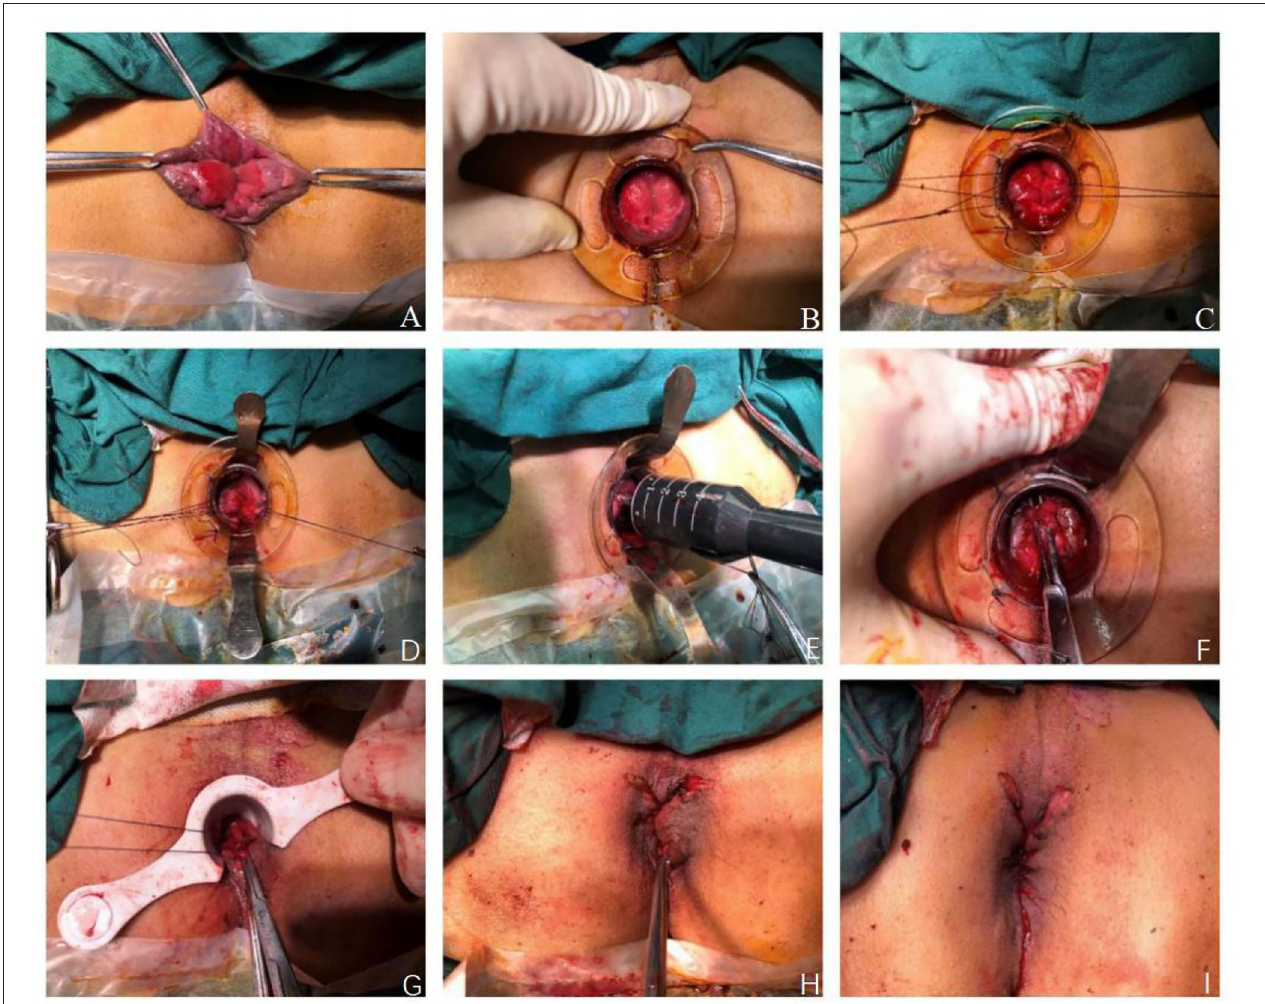
FIGURE 1 | Patients with prolapsing hemorrhoids treated with modified TST. (A) Exposing hemorrhoids with allis forceps. (B) An anoscope was inserted into the anus. (C) Purse string suture were made with 2-0 absorbable suture. (D) Two metal baffles were inserted. (E) Fired the stapler. (F) The bridges were separated. (G) The free ends of dissected mucosal bridges were ligated. (H) The external hemorrhoids were excised. (I) The perianal skin was repaired with absorbable